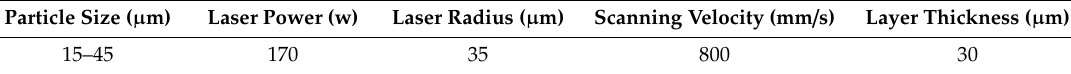
Table 2. Process parameters of SLM Ti-6Al-4V.